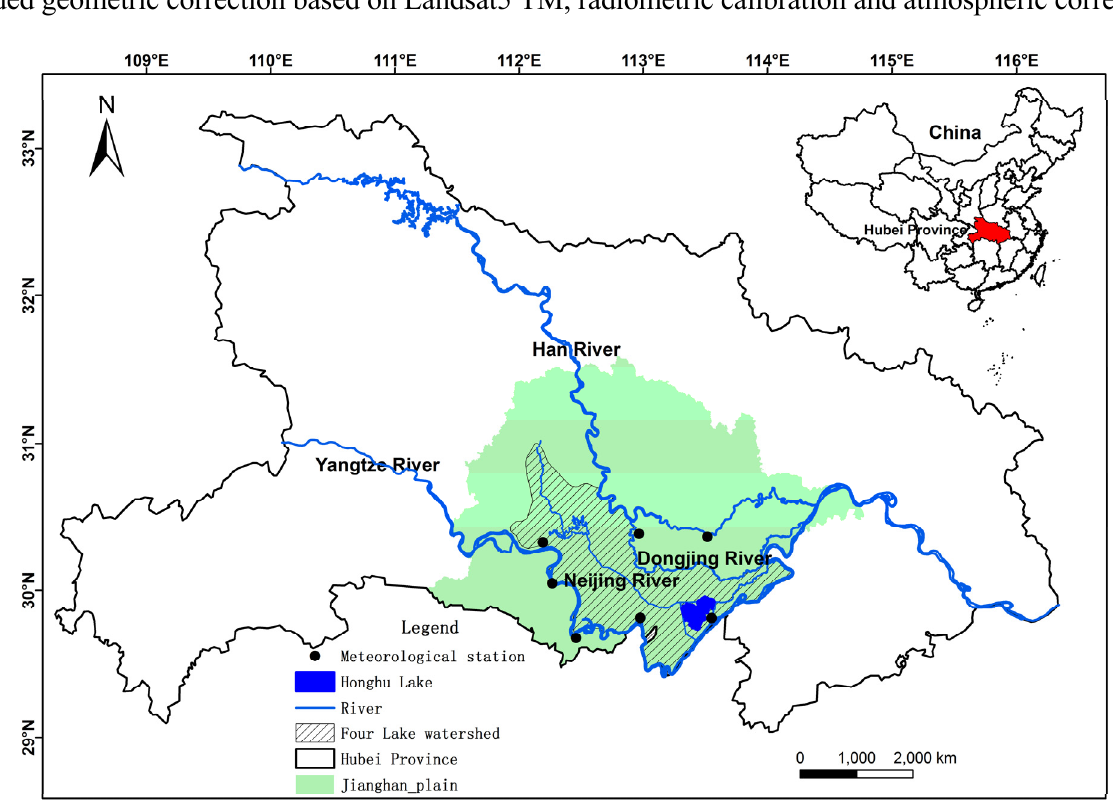
Figure 1. Location of Honghu Lake, Hubei Province,